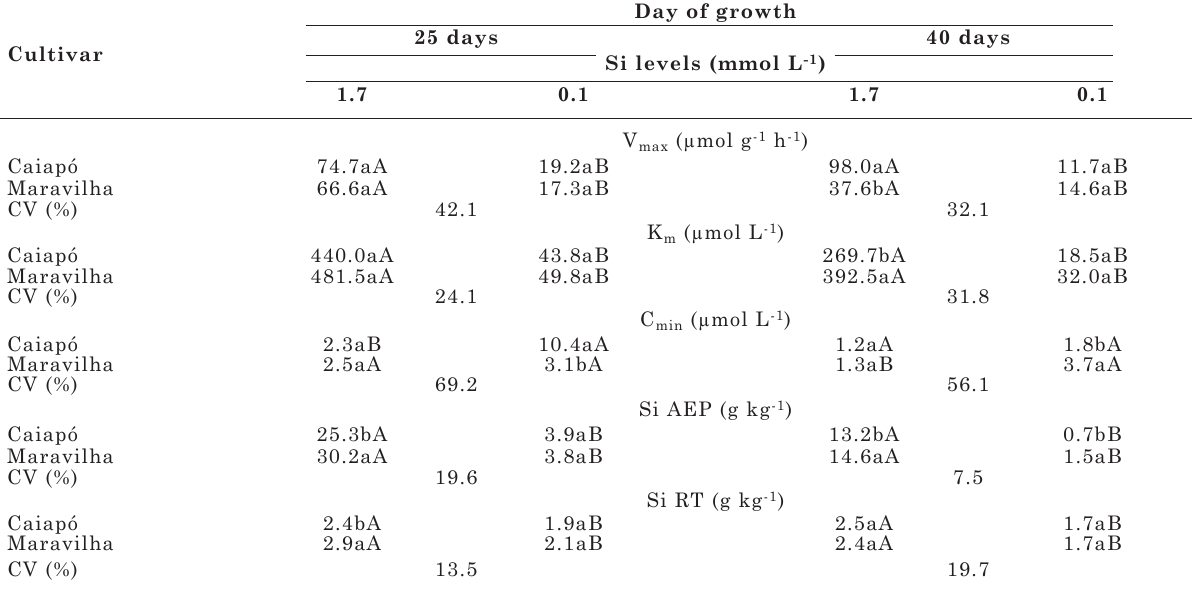
means followed by the same lower case letter in the column, and by the same upper case letter in the row, did not differ from one another by the lsD test at 5 %. cv: coefficient of variation.